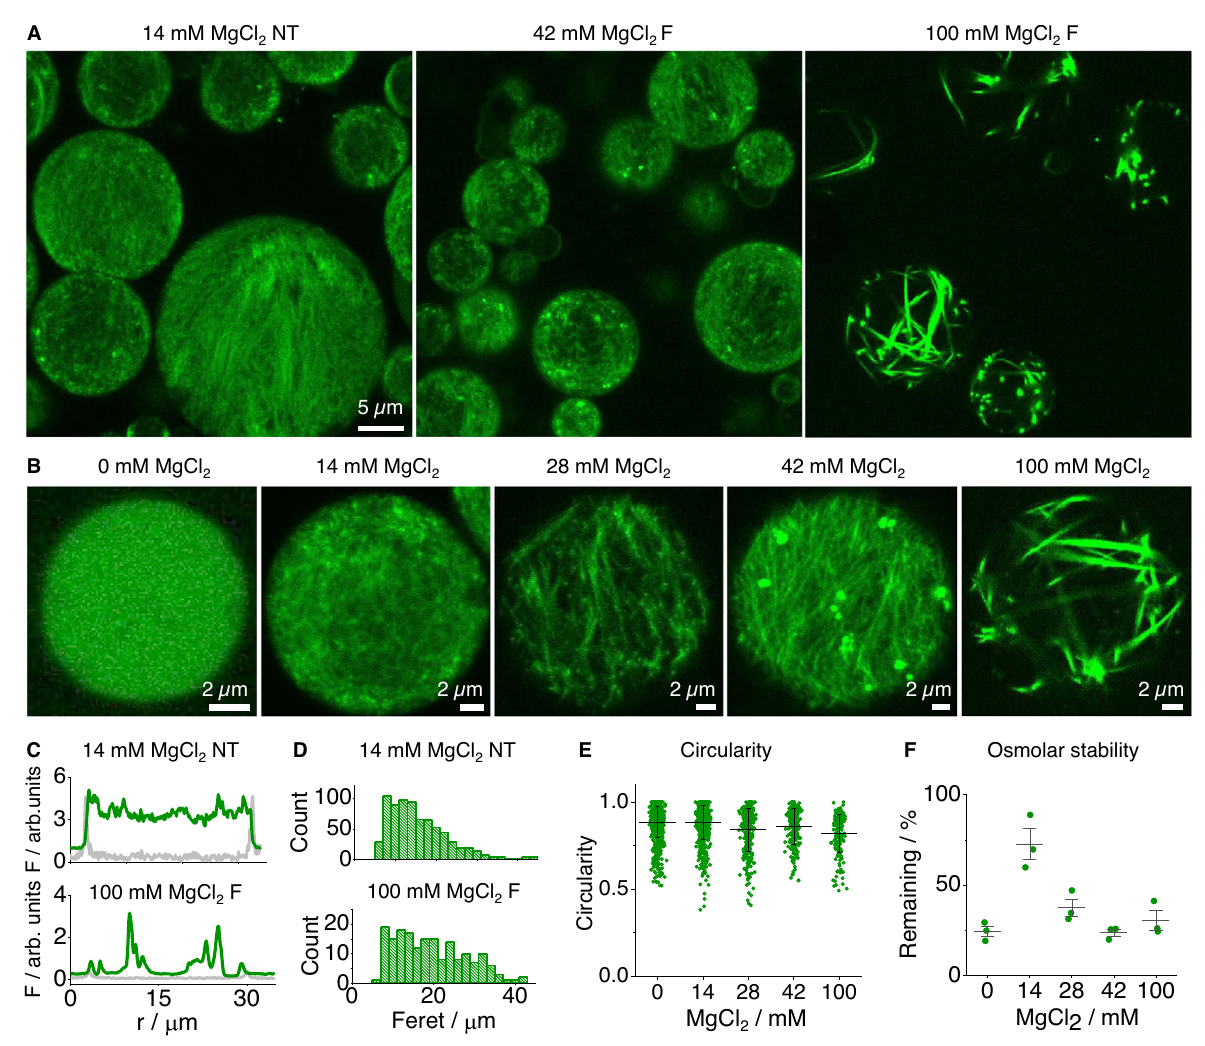
Fig. 2 | Structural characterization of protocells. A Confocal laser scanning microscope(CLSM)imagesofcompartmentalizedCy3-labeledDNAnanotubes(NT) and fi bers(F)insidegiantunilamellarvesicles(GUVs),14mMMgCl 2 DNAnanotubes, and 42 or 100mM MgCl 2 DNA fi bers inside POPG GUVs, scale bar 5 µ m. B Left to right, comparison of GUVs with encapsulated DNA nanotubes and fi bers pre-folded with increasing MgCl 2 concentration, all scale bars 2 µ m. C CLSM-derived cross section pro fi les of DNA nanotubes and fi bers, membrane-lipid channel (gray line)